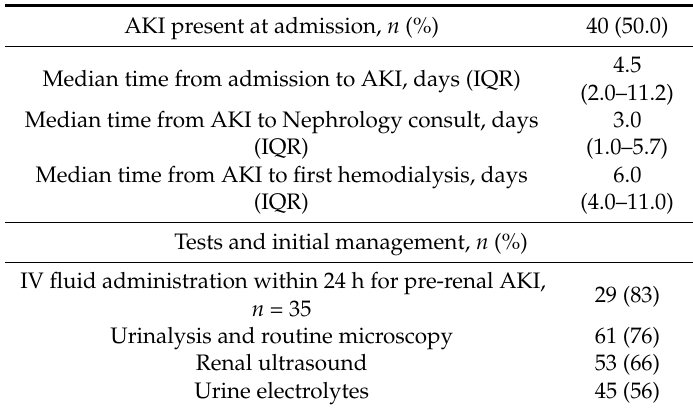
Table 2. Diagnosis and management of Acute Kidney Injury, n = 80